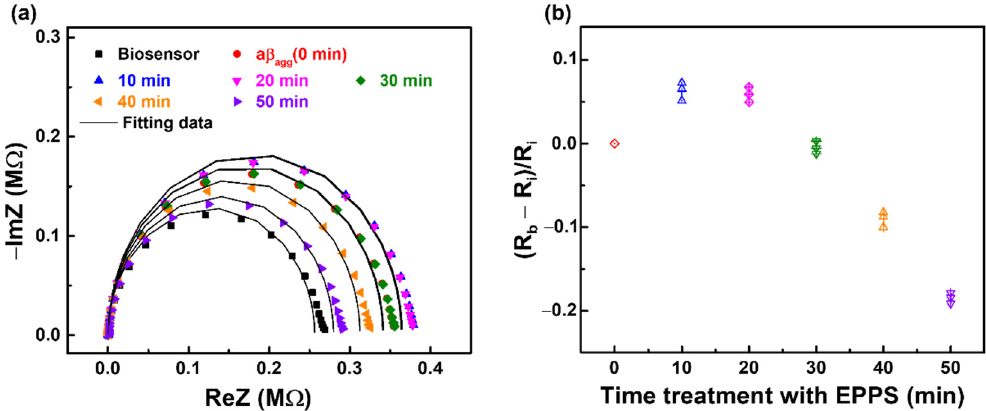
Sensors 2021 , 21 , x FOR PEER REVIEW